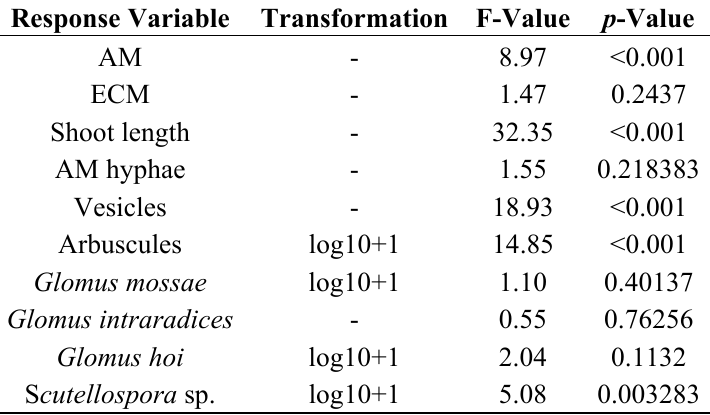
Table 5. ANOVA table of the LMMs showing the fixed effect of clone type on the different response variables while accounting for former land use type (C-, G-, P- and S-soil) as a random effect; degrees of freedom ( df ): six between groups and 18 within